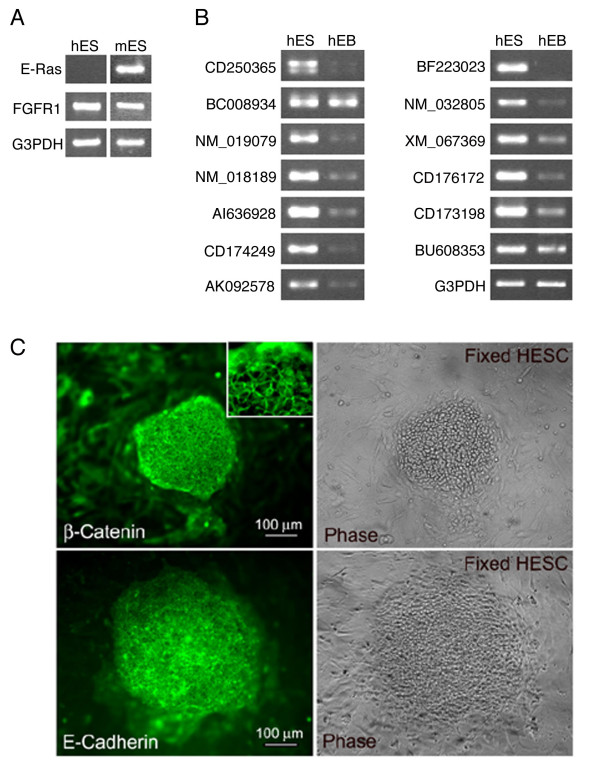
RT-PCR for E-ras/RASP, FGFR1 and novel genes identified as enriched in undifferentiated ES cells is shown in Panel A and B. Localization of E-cadherin and β-catenin in undifferentiated ES cell is shown in Panel C. All of the genes identified by MPSS and tested were present in undifferentiated ES cells and most were significantly downregulated as cells differentiated. Note the high expression at the cell surface and low or undetectable levels of β-catenin in the nucleus.